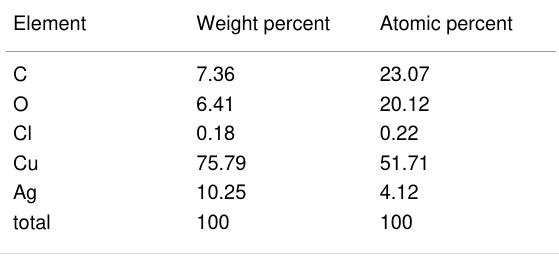
Figure 4: Weight percent of Ag for structures prepared with different feeds in the internal cavity (black squares) and the pile-ups of cavities (red circles). The details of the feed structures are given in Table